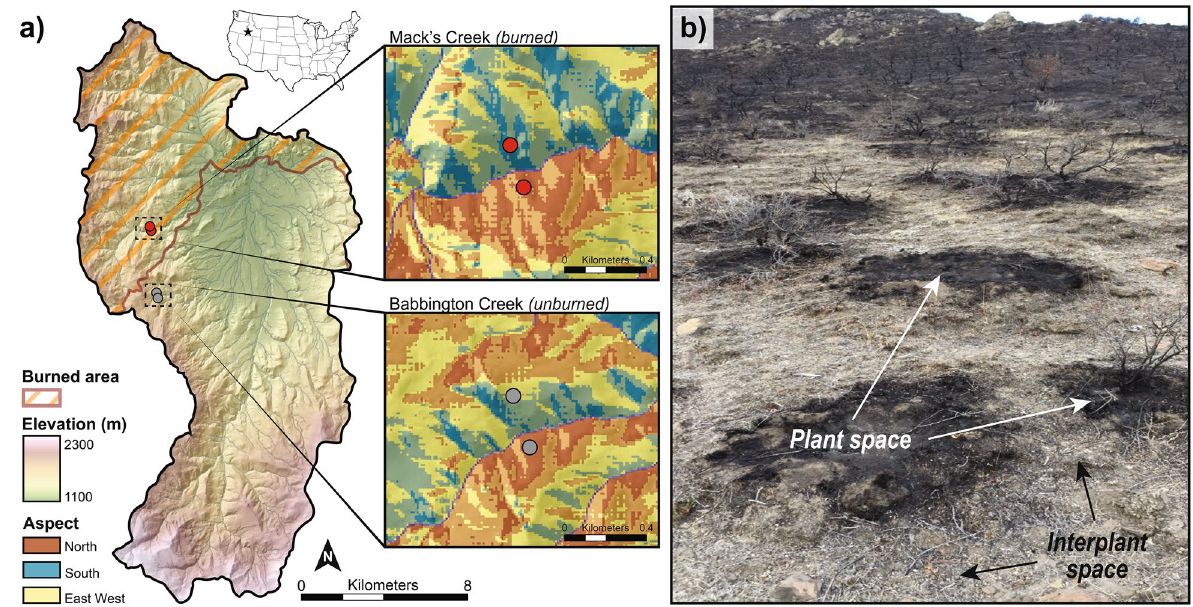
Figure 2. Aspect and microsite properties contrast in study catchments at the Reynolds Creek Experimental Watershed-Critical Zone Observatory (RCEW-CZO) in Southwestern Idaho, USA. ( a ) North- and south- facing aspects within Mack’s Creek (burned) and Babbington Creek (unburned) in the RCEW-CZO. ( b ) Image highlights burned biomass and remanent plant-interplant spaces after the Soda fire in August